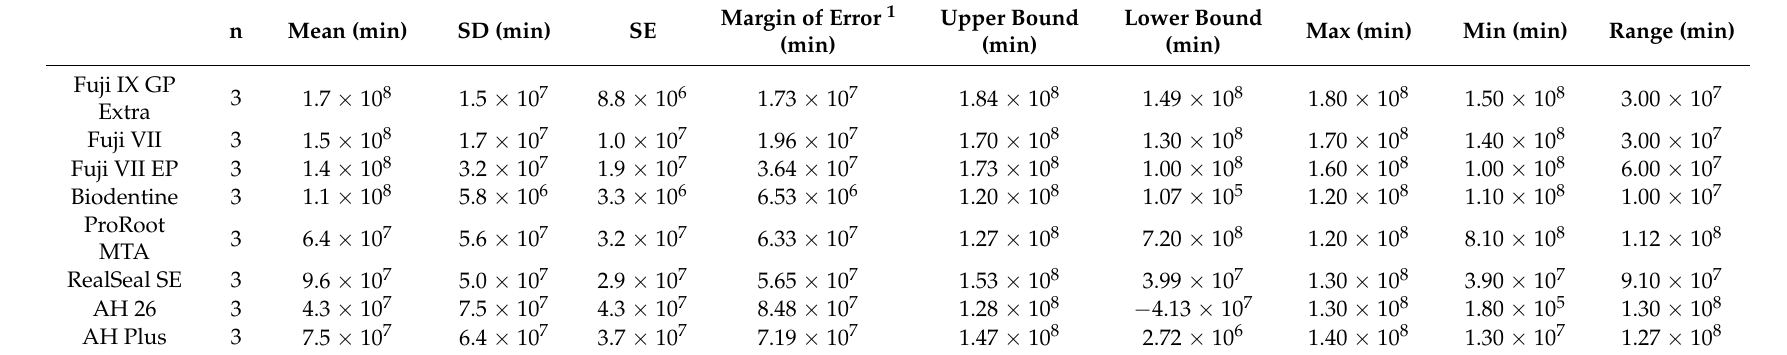
Table 1. Plateau elastic modulus (in MPa).